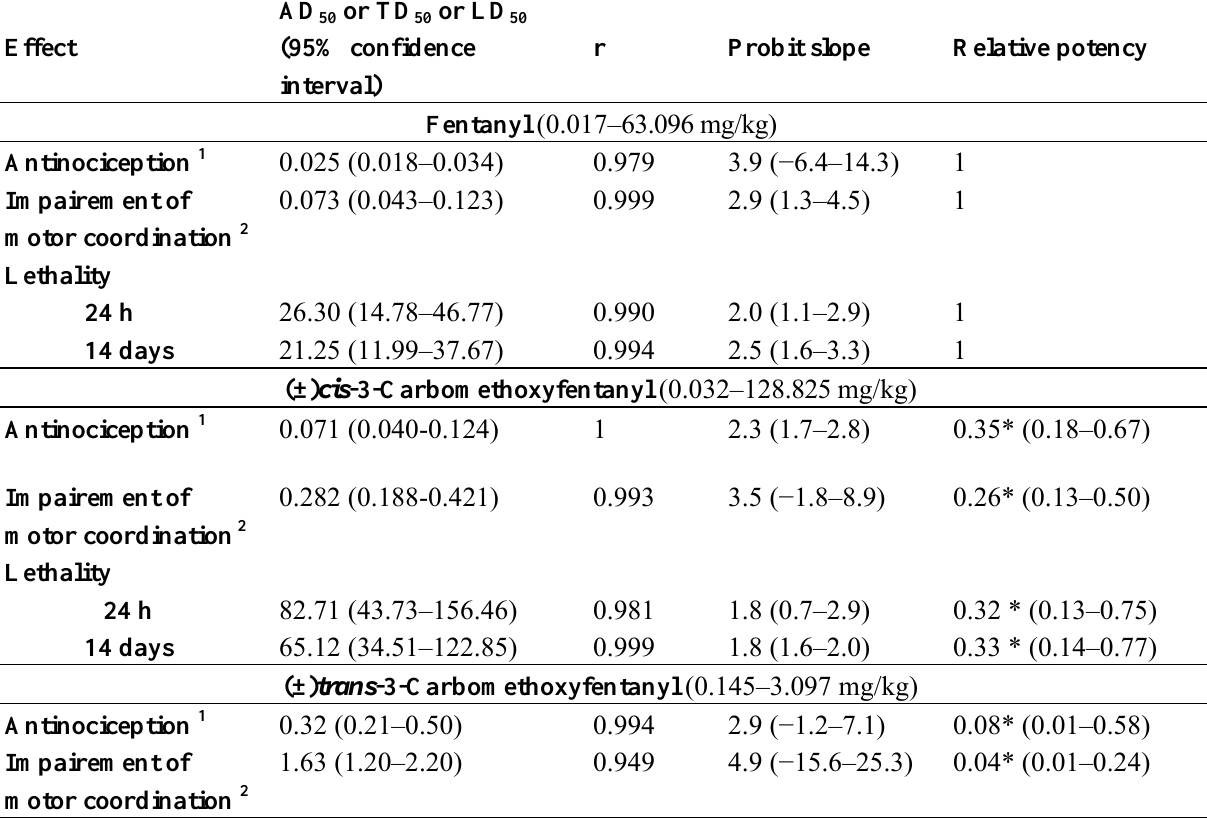
Table 1. Median effective doses for antinociception (AD ), impairement of motor 50 coordination (TD ) and lethality (LD ), correlation coefficient (r), probit slopes and 50 50 relative potencies with 95% confidence limits (95% CL) for fentanyl, (±) cis -3- carbomethoxyfentanyl and (±) trans -3-carbomethoxyfentanyl in inducing antinociception, impairement of motor coordination and lethality in